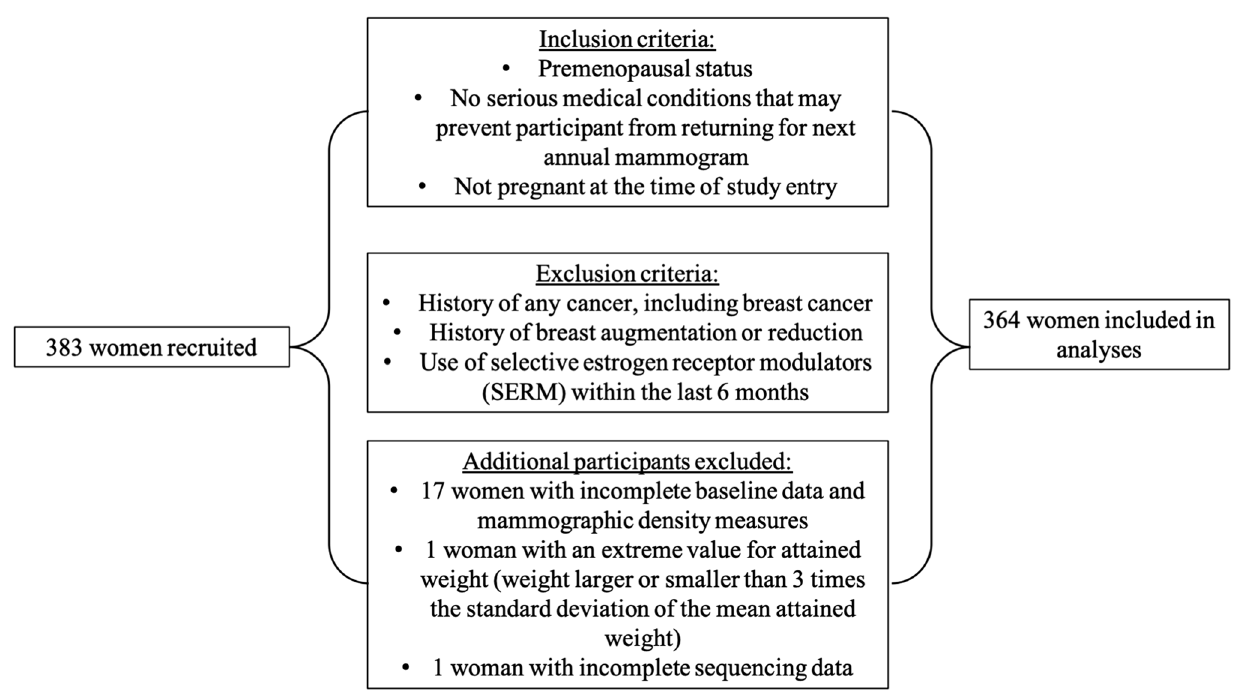
Fig. 1 Schematic depicting inclusion and exclusion criteria for study